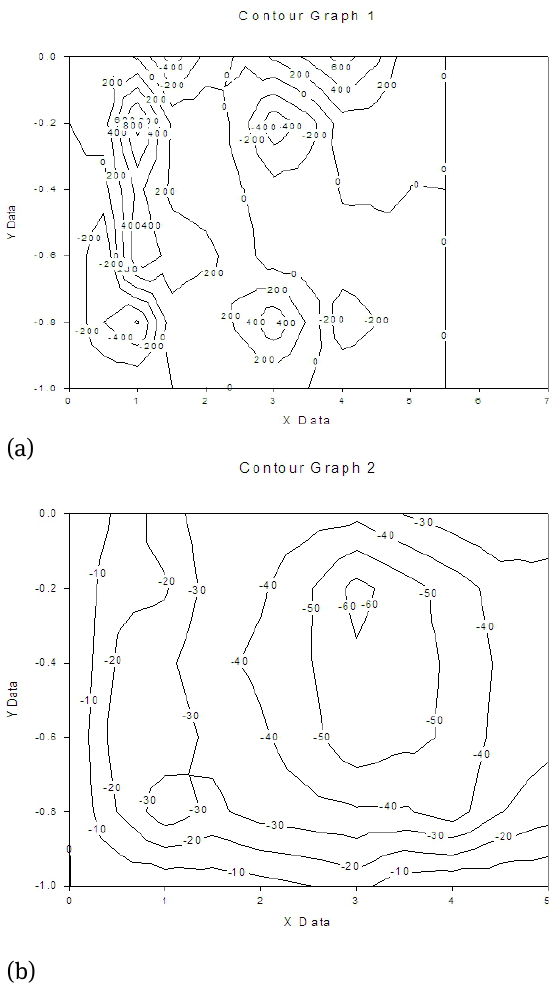
Fig. 3. (a) Contour Graph 1; (b) Contour Graph